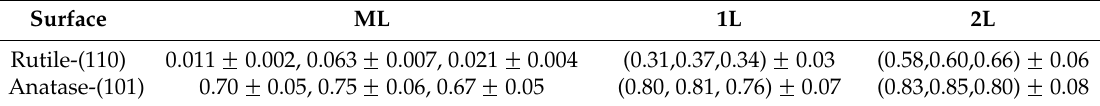
(cid:1) 9 (cid:1) 1 Table 3. Self-diffusivities [ (cid:2) 10 m 2 (cid:4) s ] (x,y,z) in adsorbed layer (ML) and second and third layers (2L & 3L, respectively) from each surface ( cf. density profiles in Figure 3 of [16]. Note that the sum of the different laboratory directions gives the total self-diffusivity. That of bulk water